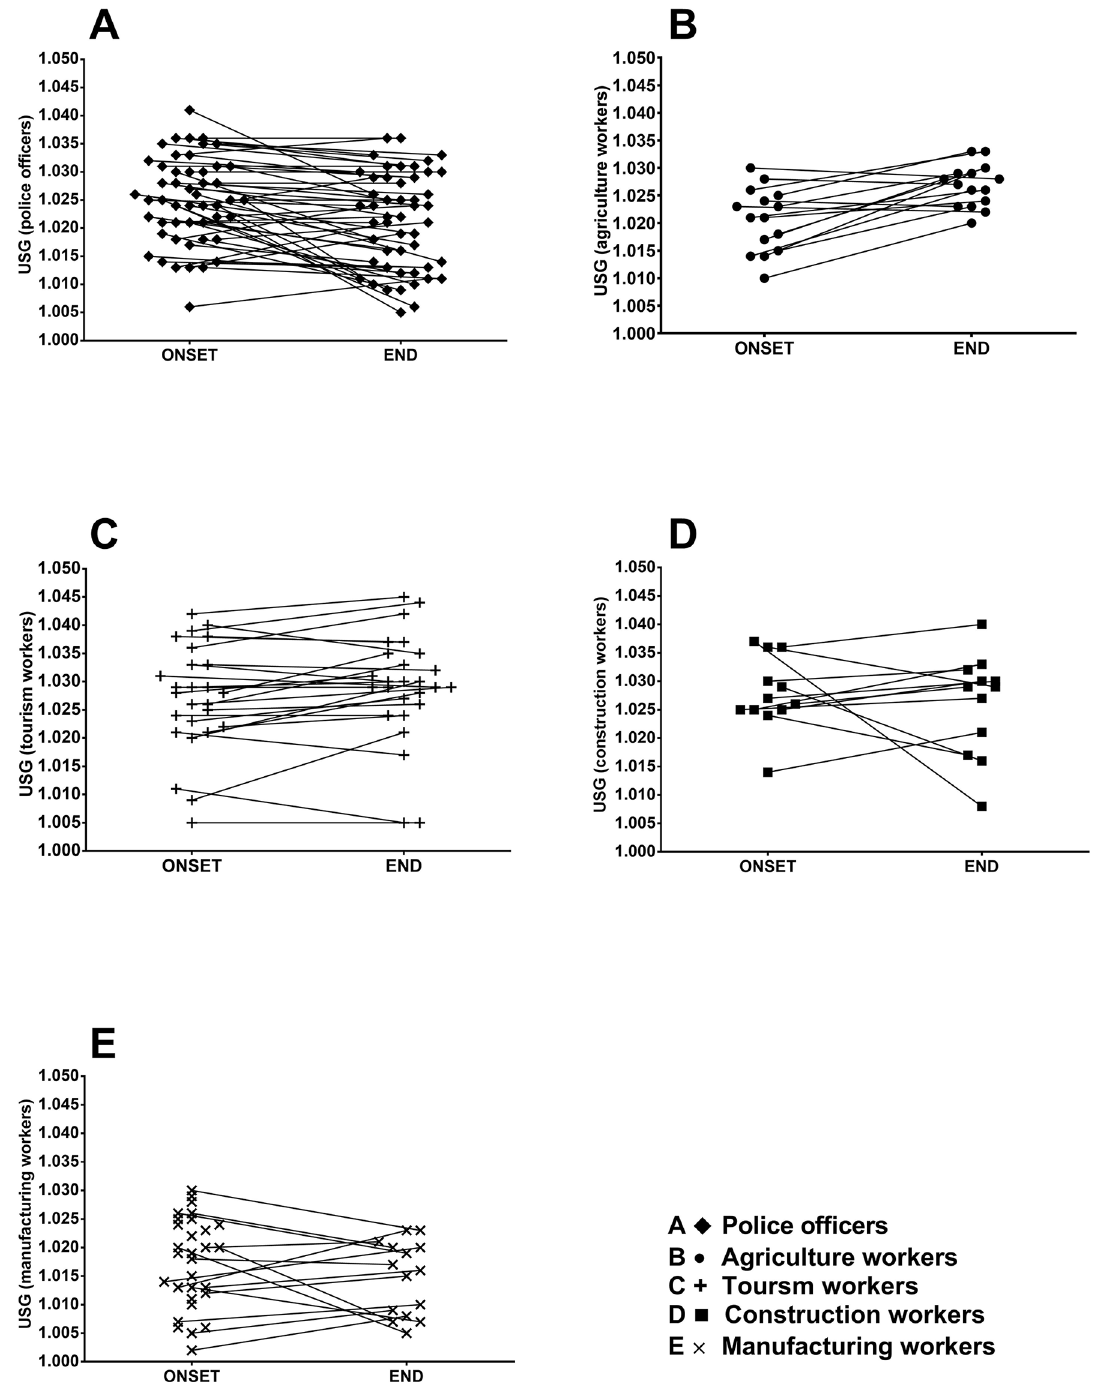
Fig 2. USG values across five different industries in four different European countries. Symbols connected with lines represents participants at the ONSET and END of a work shift. Black diamonds [ ♦ ]: Police officers, both inside the office and outdoors, uniform is required. Black dot [ ● ]: Agriculture workers, working outside with no protective clothing requirements. Black crucifix [+]: Tourism workers, inside the office and outdoors. Black square [ ■ ]: Construction workers, required to wear protective clothing. Black cross [ X ]: Aluminum extrusion workers, required to wear protective